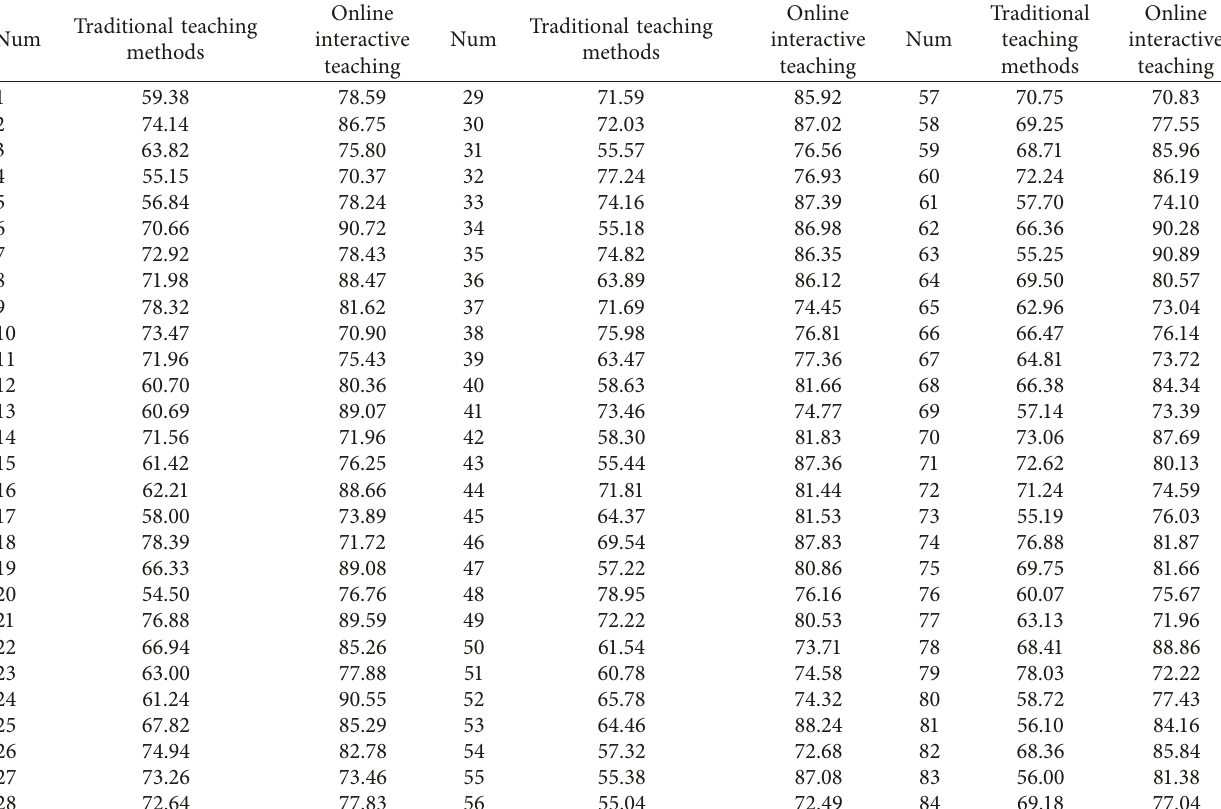
Table 1: Comparison of teaching